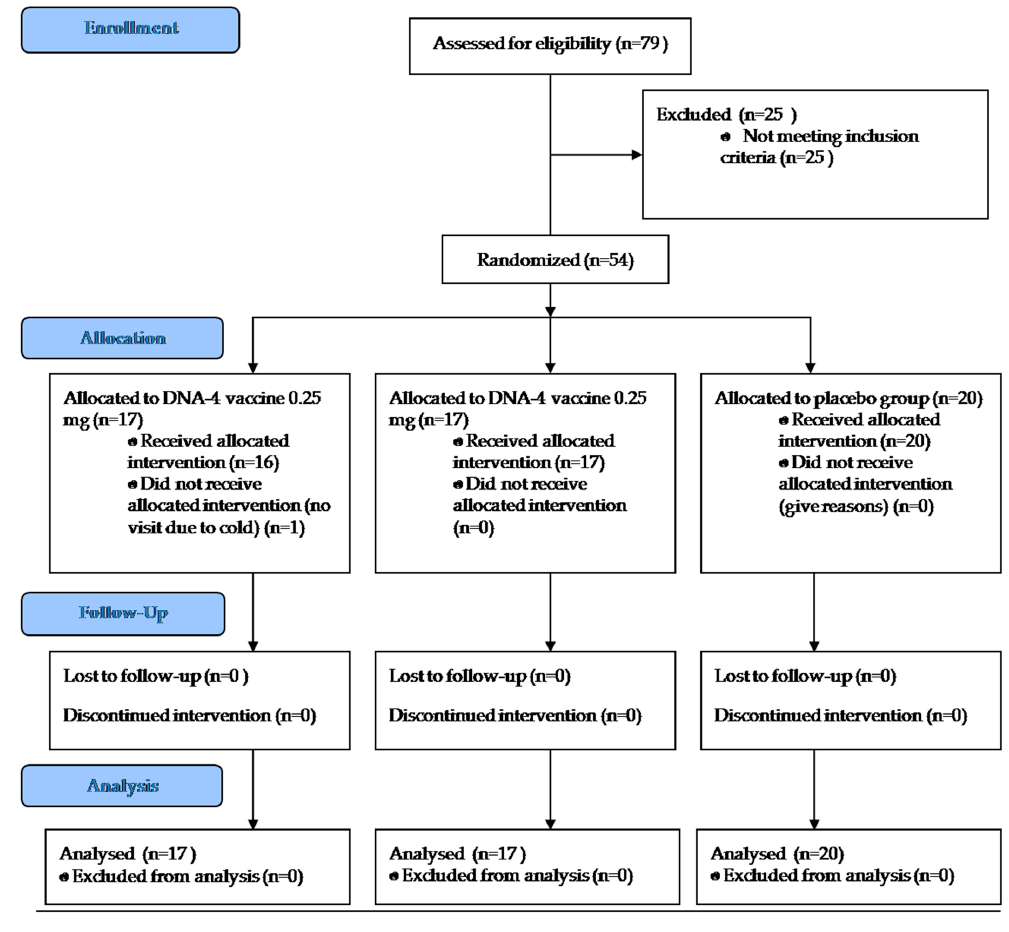
Figure 2. Consort diagram of the study. Table 2. Adverse events registered in trial participants.